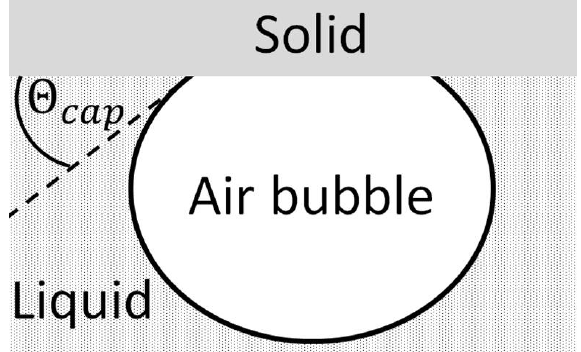
Figure 5. Application of the air bubble in a liquid environment. Formation of the inverted contact angle using the “captive bubble” method; here, cos θ = 180 − cos θ cap .